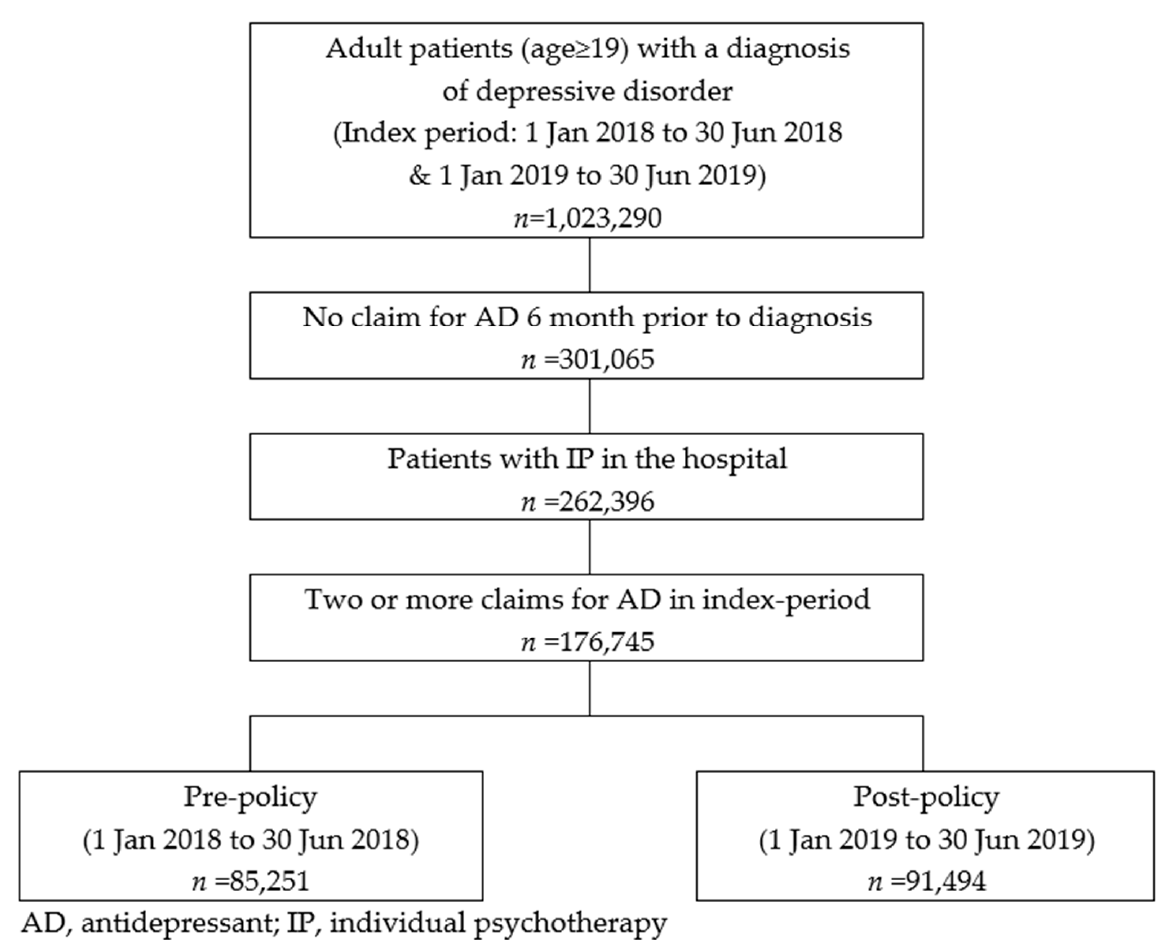
Figure 2. Summary of study design and population.